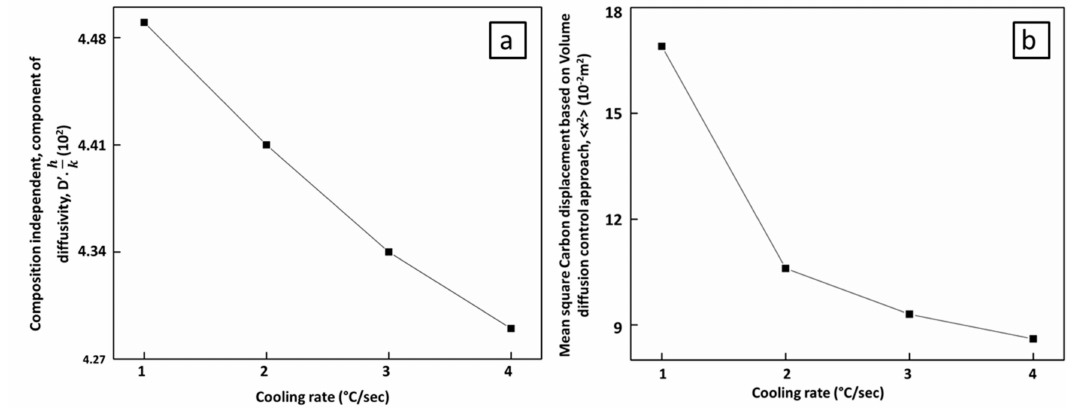
Figure 11. Based on volume-controlled di ff usion of carbon. ( a ) Component of di ff usivity of carbon at various cooling rates. ( b ) Mean square displacement of carbon at various cooling rates.